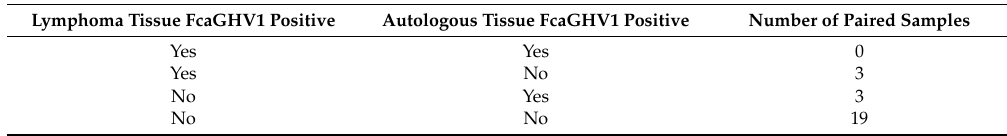
FFPE = formalin-fixed, paraffin embedded. Table 2. Paired-sample combinations analysed for FcaGHV1 DNA distribution in lymphoma compared to autologous non-lymphoma tissue using McNemar’s exact test.